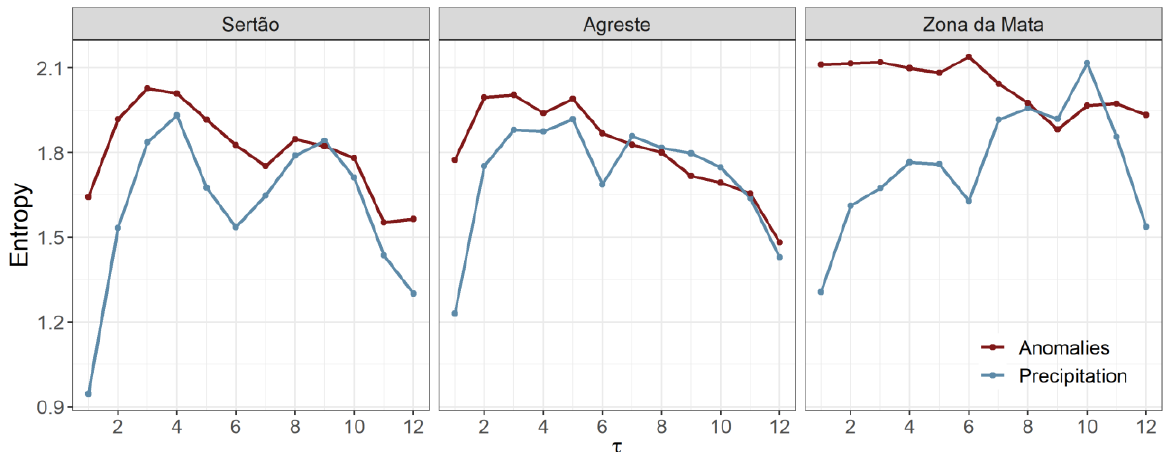
Figure 4. MMSE for monthly rainfall and monthly anomalies for three representative stations. For both the smallest ( τ = 1) and the largest ( τ = 12) temporal scales, the lowest entropy values for the original series are found for the Sert ã o region due to the most pronounced separation of the dry and rainy seasons. More precisely, the dry season in Sert ã o lasts 9 months, resulting in high monthly regularity and low entropy for τ = 1, while the strong annual seasonality results in low entropy for τ = 12. For all regions, the original series display lower entropy for τ = 1 than for τ = 12 indicating that intra-annual regularity is more pronounced than interannual seasonality, and this difference is larger for Sert ã